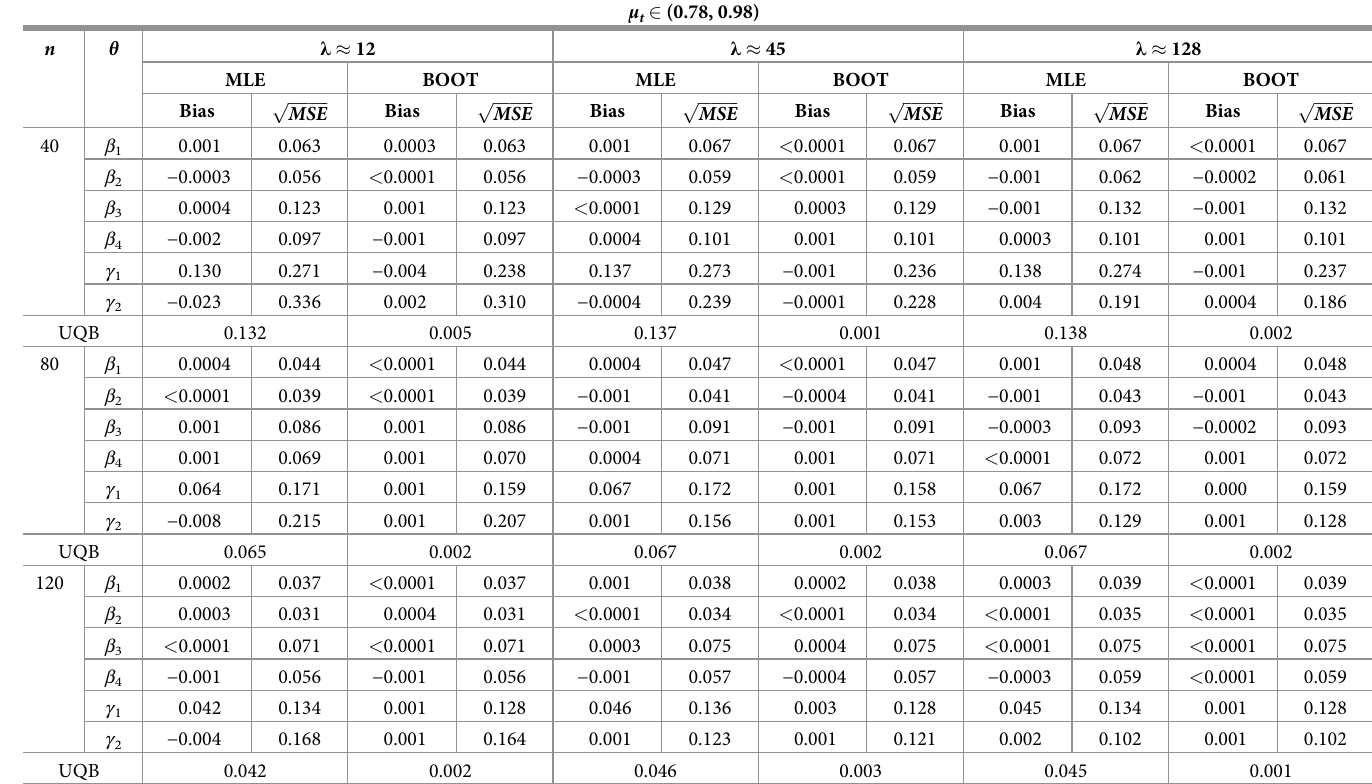
= 1 (cid:0) μ Þ ¼ β þ x β 2 þ β þ β and log ð σ 2 Þ ¼ γ þ z γ 2 , β = (2.1, − 1.5, − 1.6, − 1.2) > , μ t 2 (0.78, 0.98), t = 1, ... , n x x t t 2 t t 1 3 t 3 4 t 4 1 t